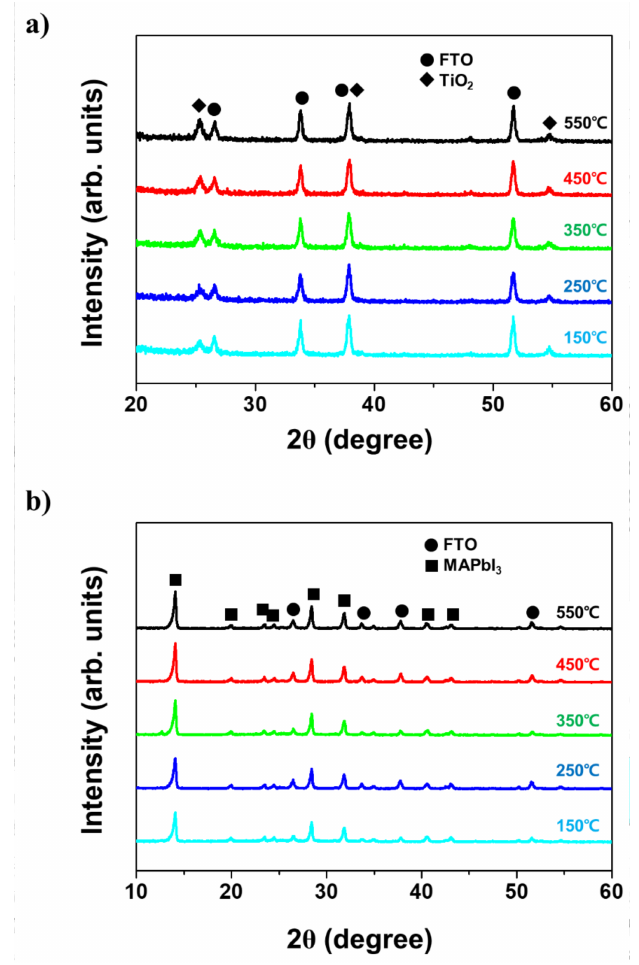
Figure 1. X-ray di ff raction spectra of ( a ) mesoporous TiO 2 and ( b ) CH 3 NH 3 PbI 3 light-absorbing layers at various TiO 2 sintering